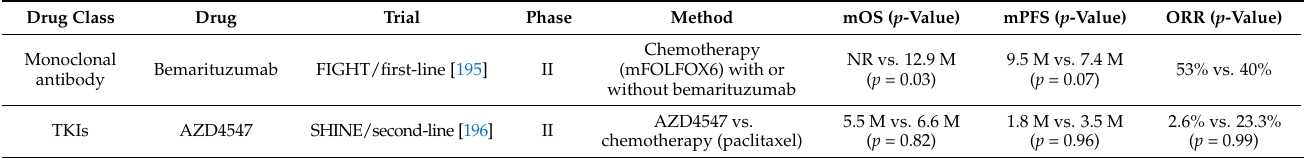
Table 7. Phase II and III trials of therapies targeting fibroblast growth factor receptor. mOS, median overall survival; mPFS, median progression-free survival; M, months; ORR, objective response rate; FOLFOX, folinic acid, fluorouracil, oxaliplatin.